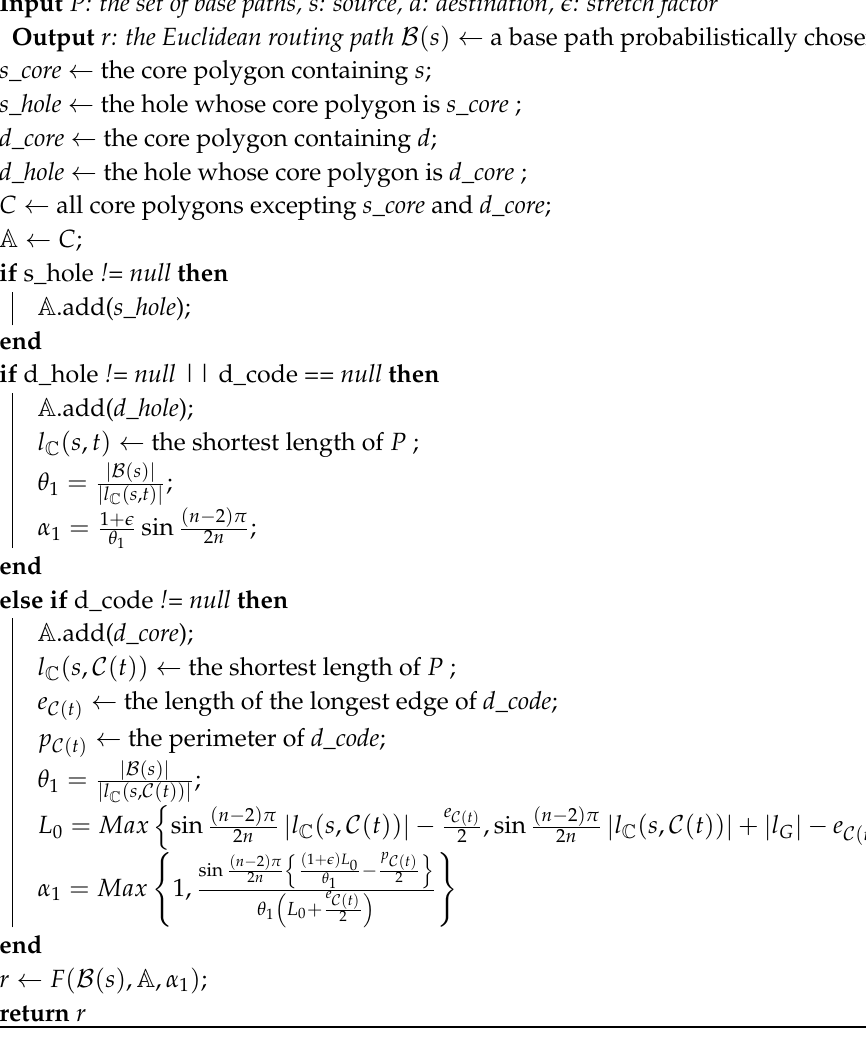
Algorithm 2: Euclidean routing path determination